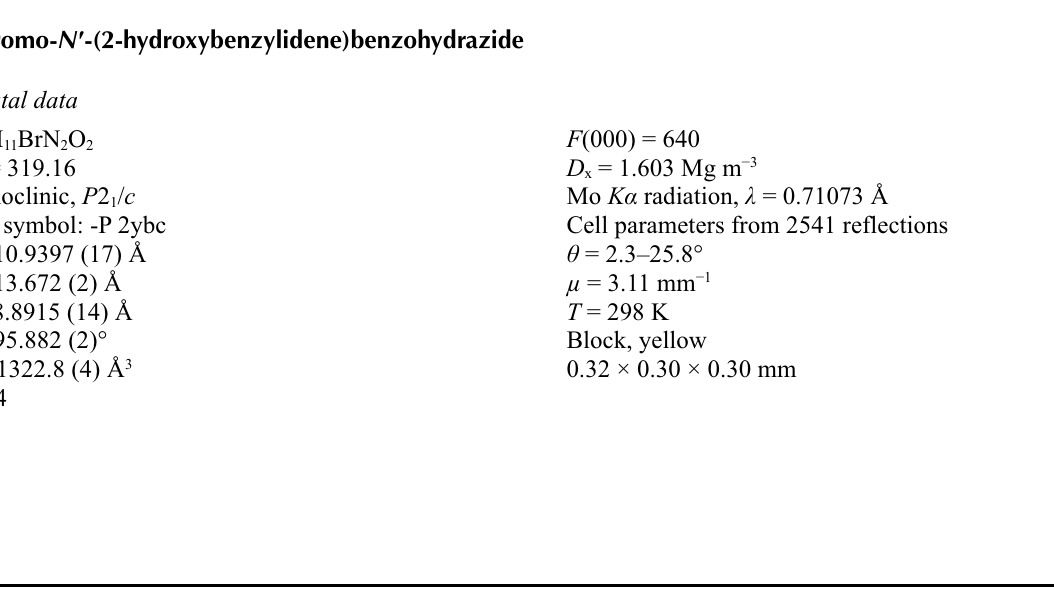
Figure 2 The crystal packing of the title compound, viewed along the b axis. Hydrogen bonds are shown as dashed